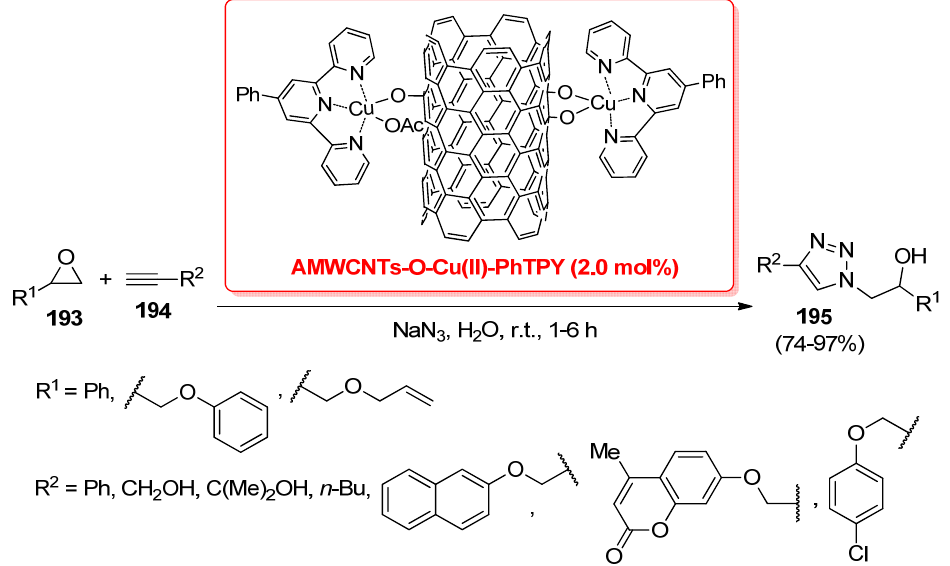
Scheme 59. Synthesis of β -hydroxy-1,4-disubstituted triazoles 195 by tandem azide formation/[3 +